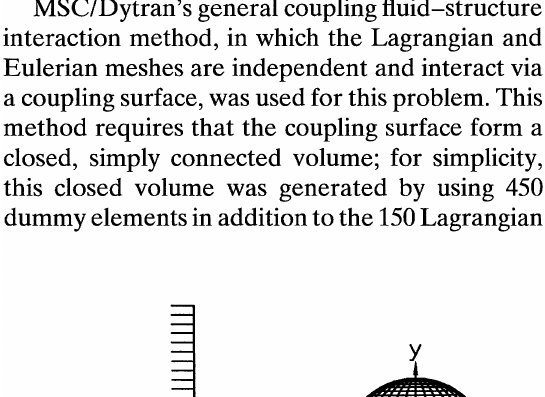
FIGURE 2 TNT detonation peak pressures for various model discretizations.